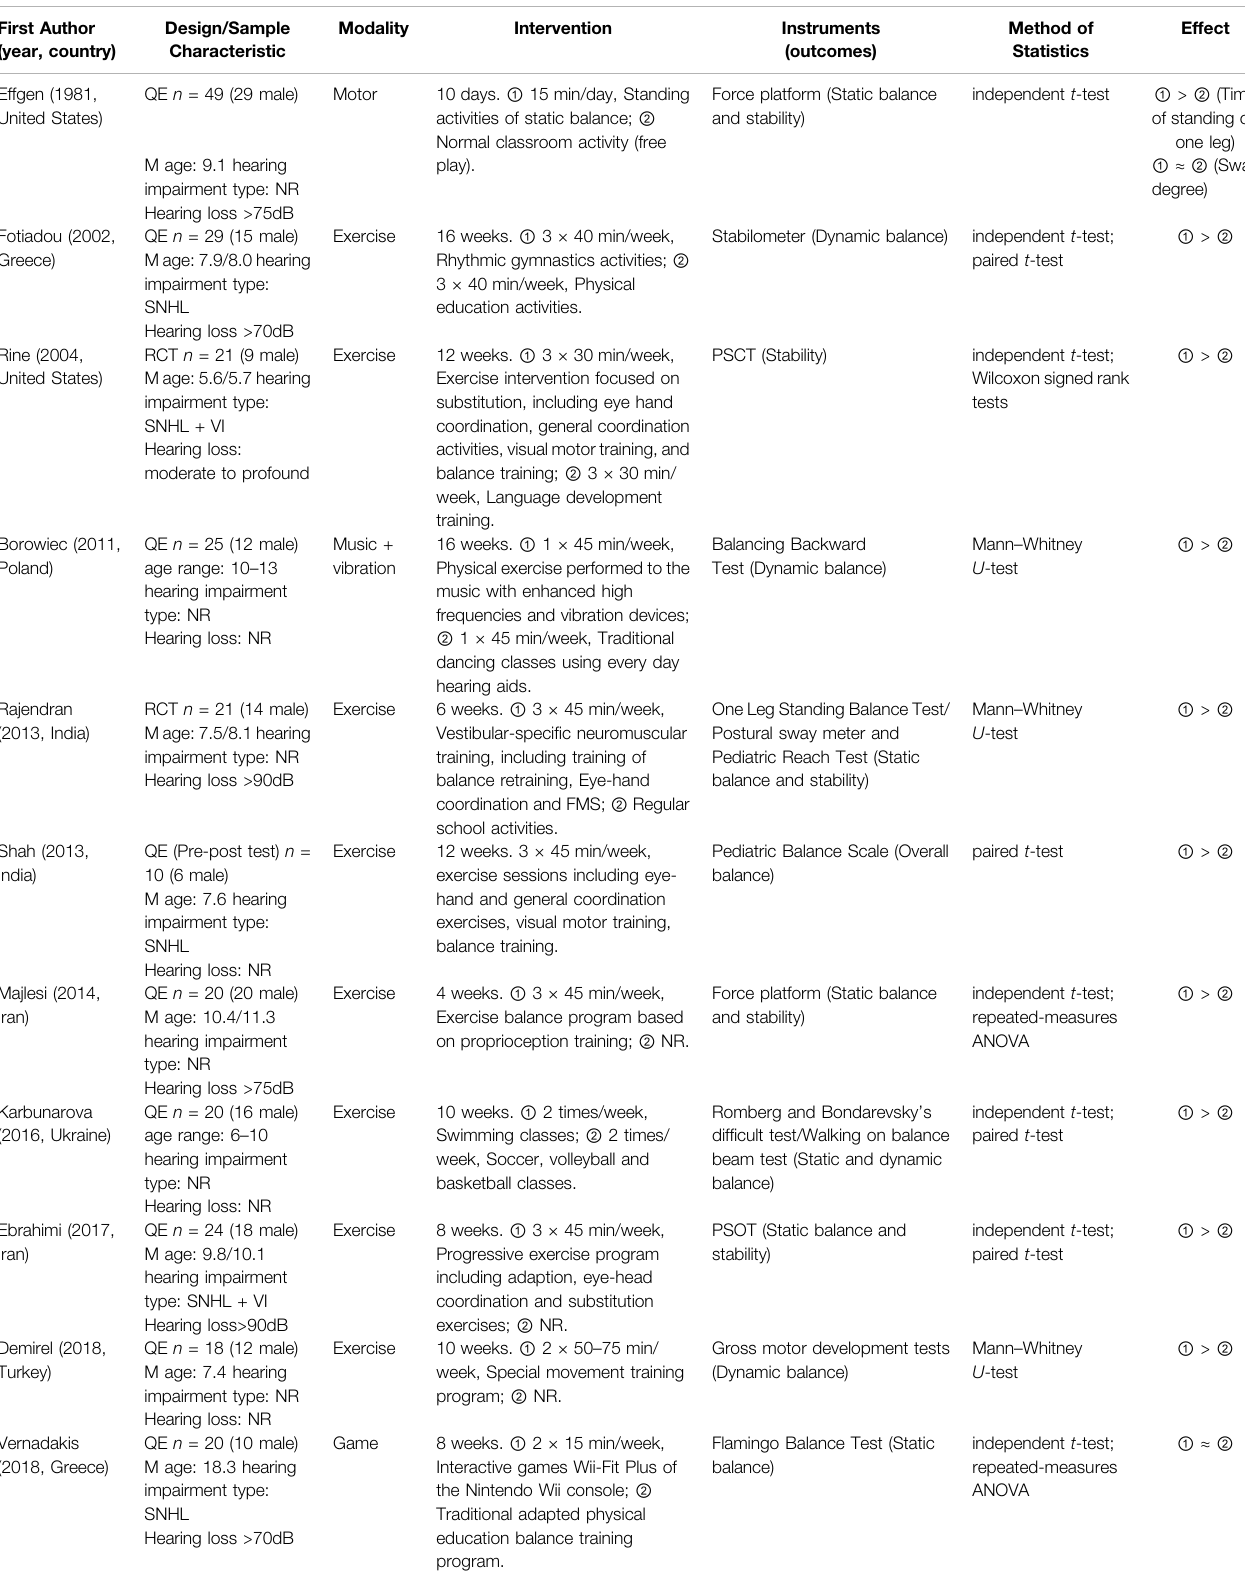
TABLE 3 | Characteristics of included